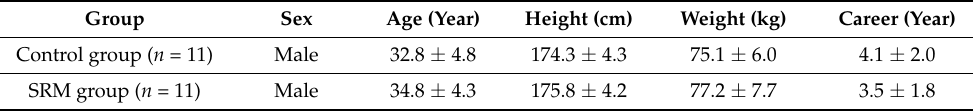
Table 1. Characteristics of study subjects.